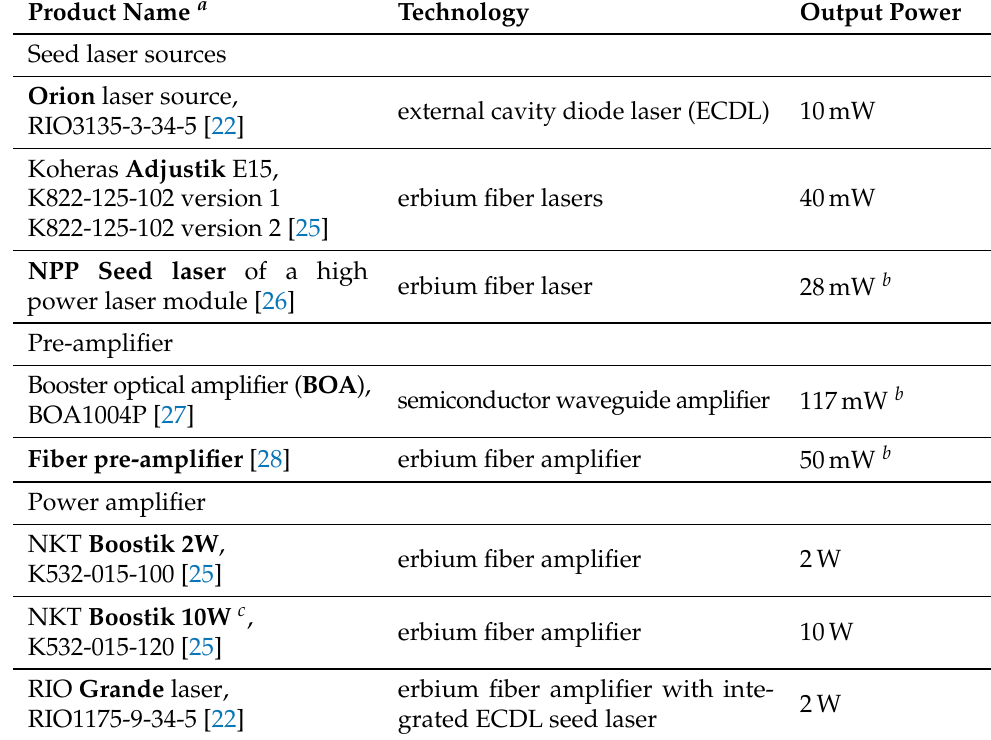
Table 1. Tested laser sources and